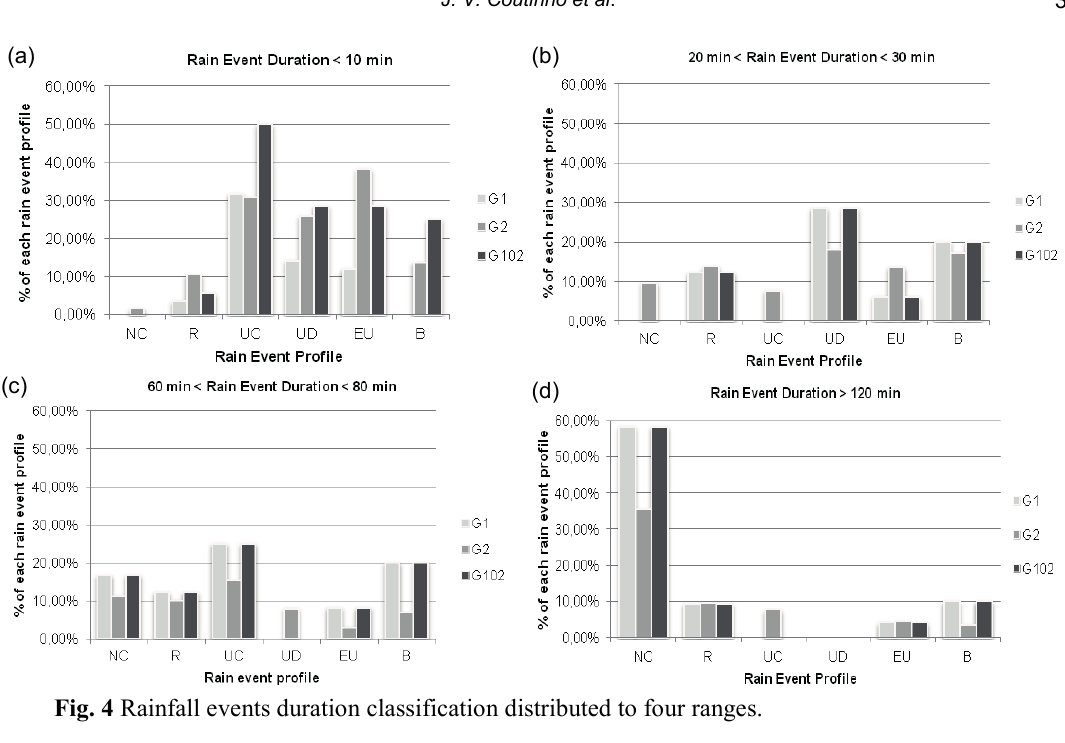
Fig. 4 Rainfall events duration classification distributed to four ranges.